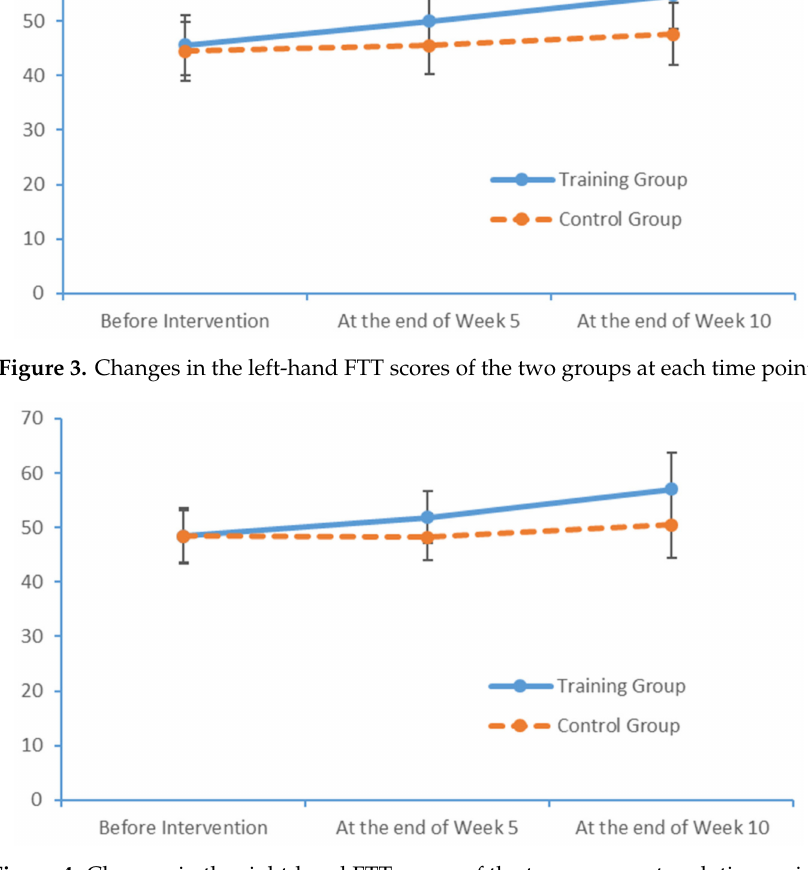
Figure 4. Changes in the right-hand FTT scores of the two groups at each time